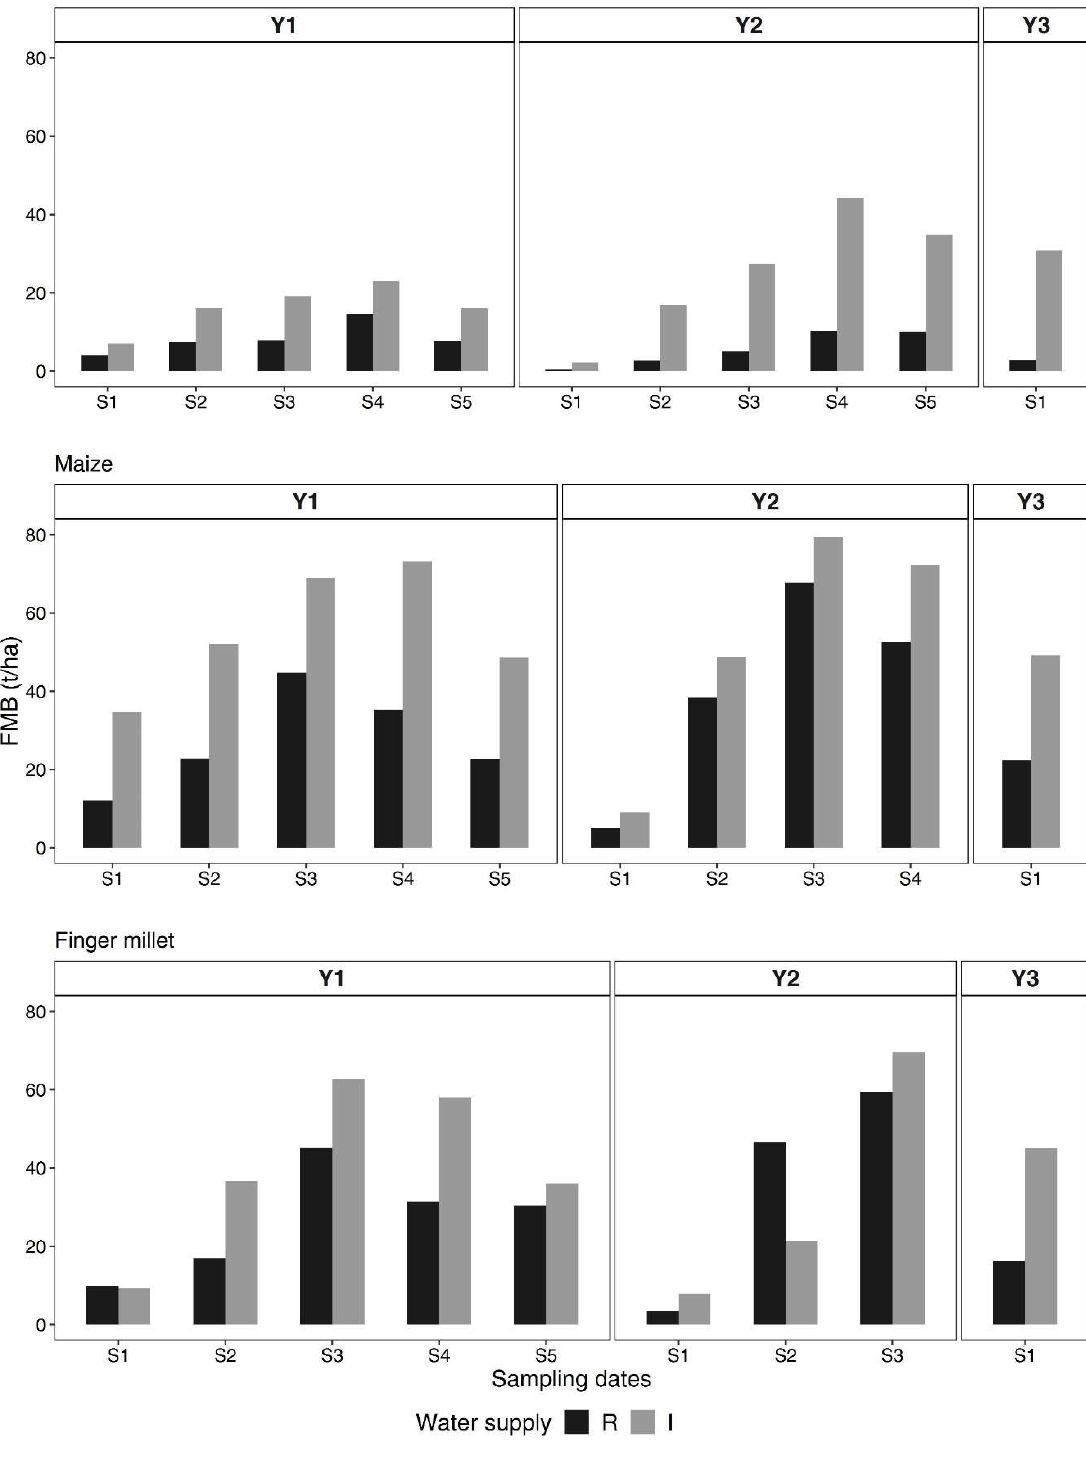
Figure 3. Fresh matter biomass (FMB) in the rainfed (R) and irrigated (I) experiment for 2016–2018 (Y1–Y3). The diagrams show average values over three levels of N fertiliser application. To gain an impression of the spectral variation for each crop, minimum, average and maximum spectral reflectance from the images of rainfed and irrigated experiments were determined for the three crops lablab, maize and finger millet during the three monsoon seasons (Figure 4).